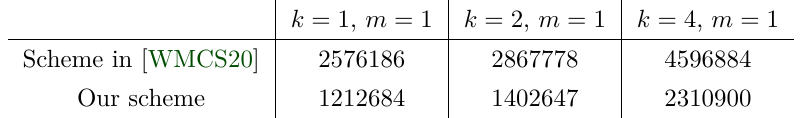
Table 8: Performance comparison indicated by clock cycles for AES-128